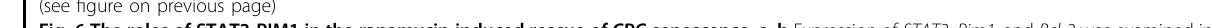
CD133 + cells 58 . Whether physiological changes such as hypoxic preconditioning affect cell differentiation and reg- ulate speci fi c lineage differentiation remains unclear.